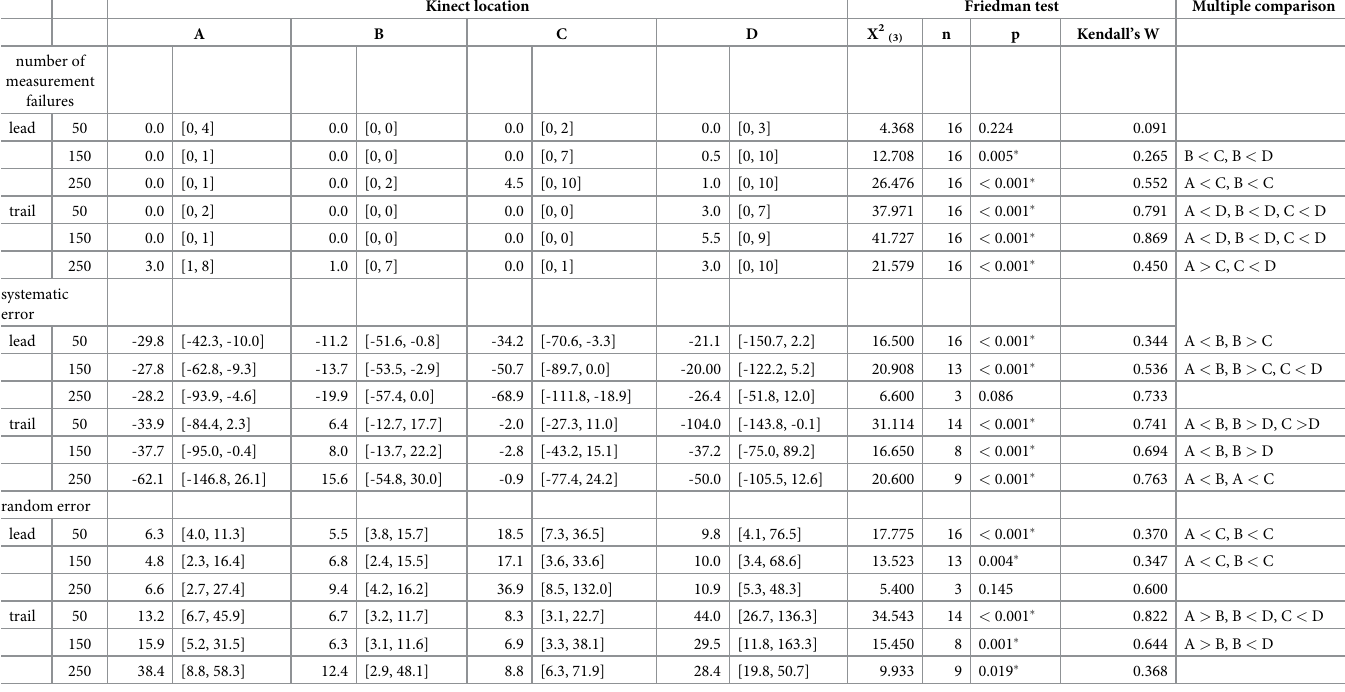
Table 1. Comparison of foot clearance measurement performance between Kinect